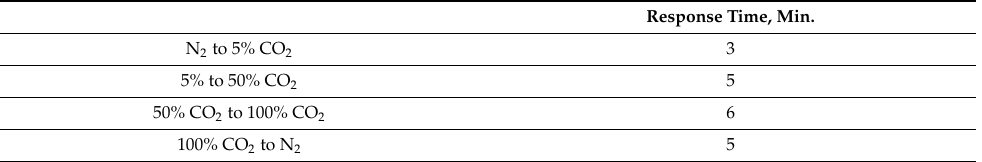
Table 2. Response time of sensor switching from different concentrations of %CO 2 . Reversibility was established with N 2 purging; the intensity can be brought to a baseline via N 2 purging to start a new cycle.